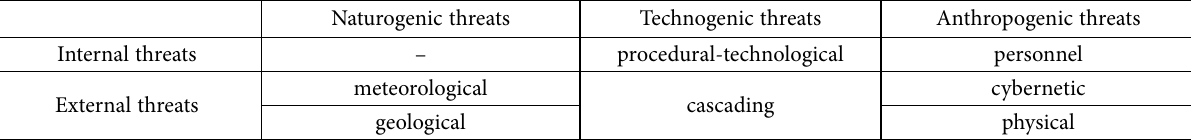
Table 1. Classification of threats for assessing cascading effects in critical infrastructure system